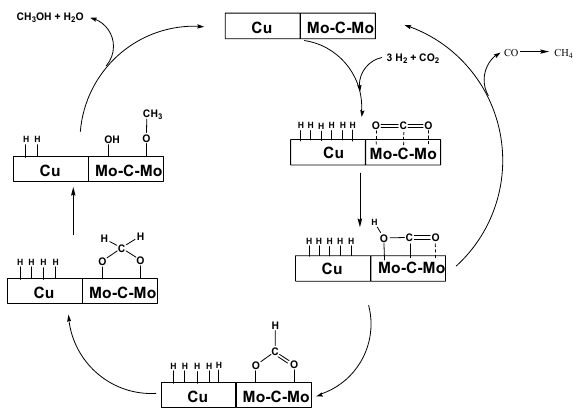
Scheme 1. Proposed reaction mechanism for CO 2 hydrogenation over Cu–Mo 2 C/M41 catalysts.